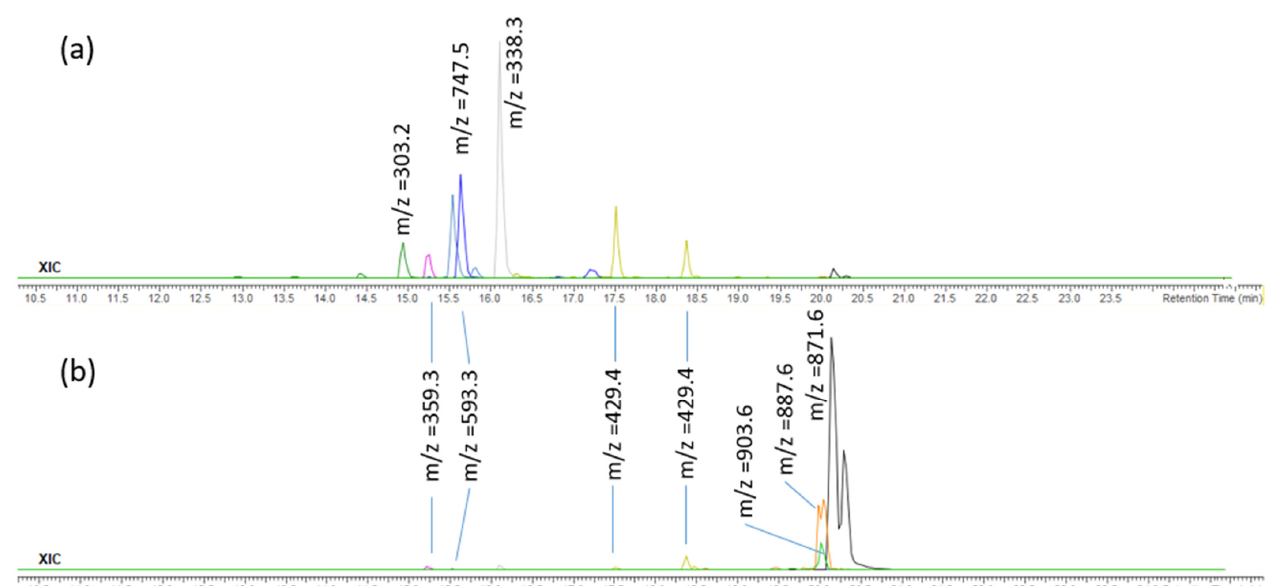
Figure 3. Total ion chromatogram (TIC) of the fractions ( a ) F3 and ( b ) F4.